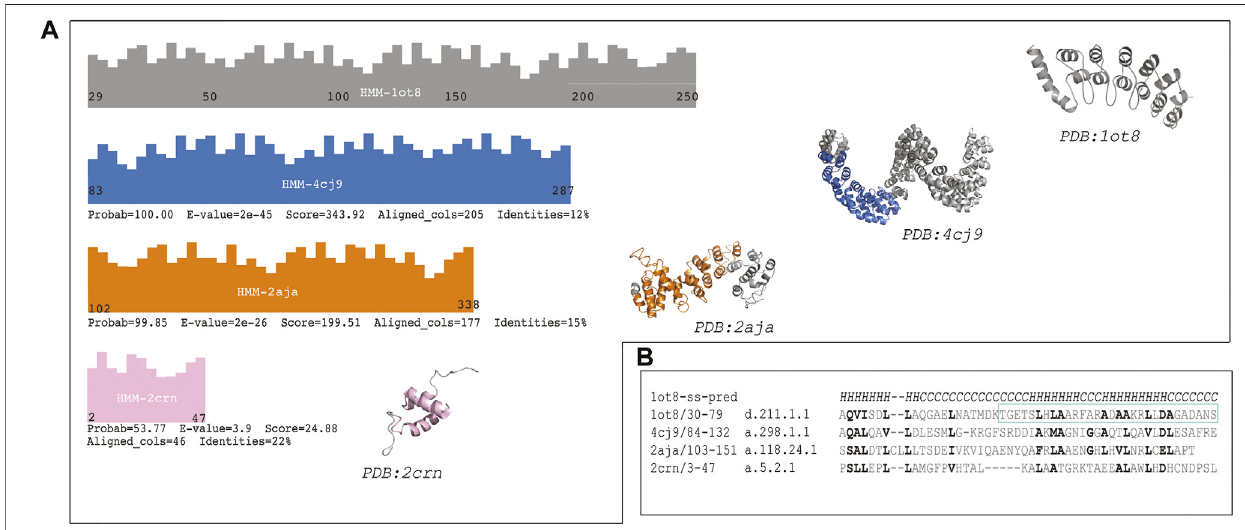
FIGURE 2 | The sequence of the Ankyrin Domain of the Drosophila Notch Receptor was used to build a Hidden Markov Model (HMM) to search the SCOP95 database of proteins also represented by HMMs. (A) Graphical representation of the hits from different folds (according to SCOP); three high probability hits are shown (probabilitybetterthan50%).Foldinblue: (A) 298:Left-handed alpha-alphasuperhelix,whichisaTAL(transcriptionactivator-like) effector. Thehitcovered 205columns (left) and the region aligned in the protein is shown in blue on the structure (right). Fold in orange: (A) 118: alpha-alpha superhelix which is a Hypothetical protein LPG2416 RuVZ. The hit covered 177 columns (left) and the region aligned in the protein is shown in orange on the structure (right). Fold in pink: (A) 5: RuvA C-terminal domain-like(3 helices; bundle, right-handed twist), which isaUBA domain. The hitcovered 46columns (left) and theregionaligned in the protein isshown inpink on the structure (right). (B) Multiple sequence alignment of a common region hit in the query (1ot8) by all the three previously mentioned folds. Similar or identical residues are shown in bold, and the second repeat of the Ankyrin domain is shown with a cyan rectangle ( Supplementary Figure S2